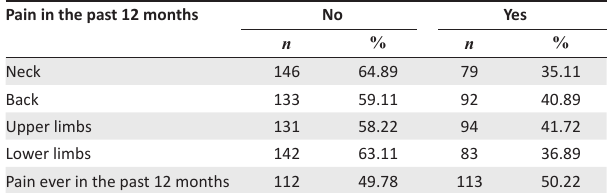
TABLE 2: Self-reported pain in the past 12 months amongst female miners in a South African gold mine in 2017 ( n = 225). Pain in the past 12